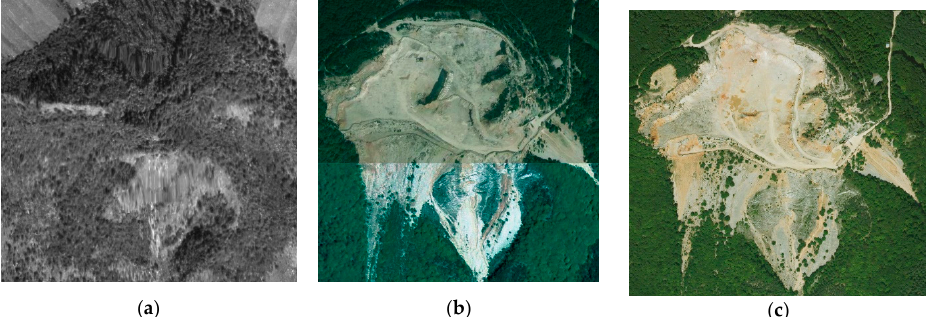
Figure 14. Spatial changes of the mineral deposit in time (Adapted from mapy.tuzvo.sk/HOFM/). ( a ) year 1950; ( b ) year 2000; ( c ) year 2017.